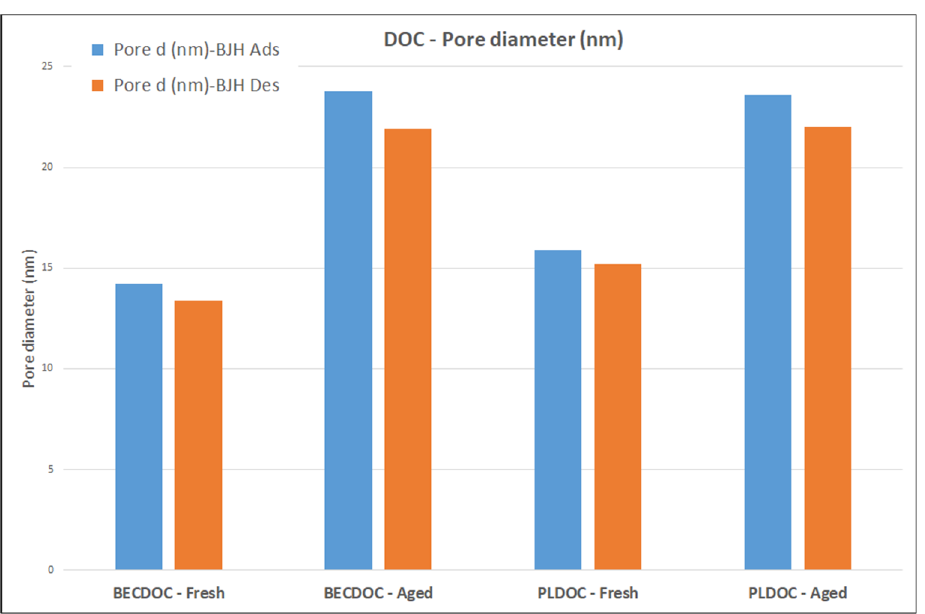
Figure 3. Pore Diameters—BJH Method: BECTWC, PLTWC.